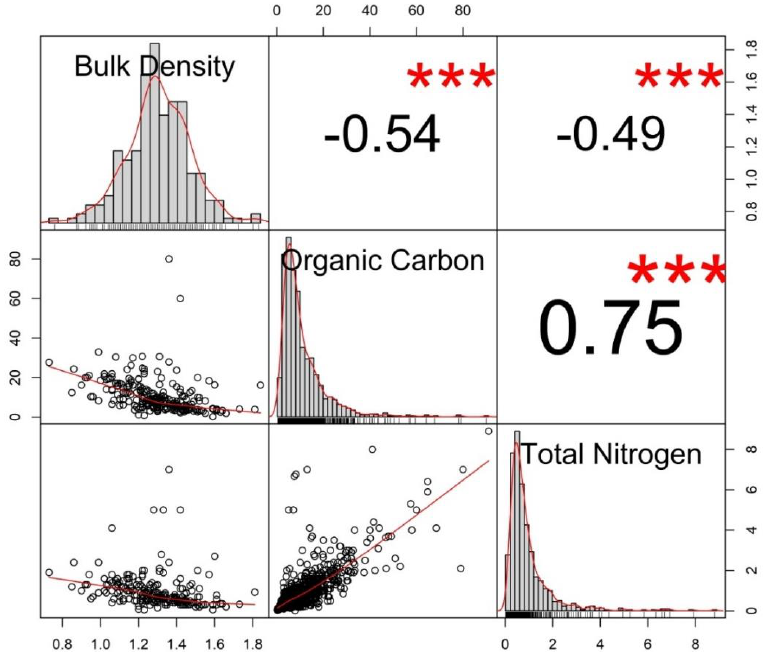
Figure 4. Scatterplots matrix of soil health indicators showing the histograms, kernel density overlays, absolute correlation, and significance levels (*** p < 0.001) of correlations between bulk density, organic carbon, and total nitrogen (before data imputation) .